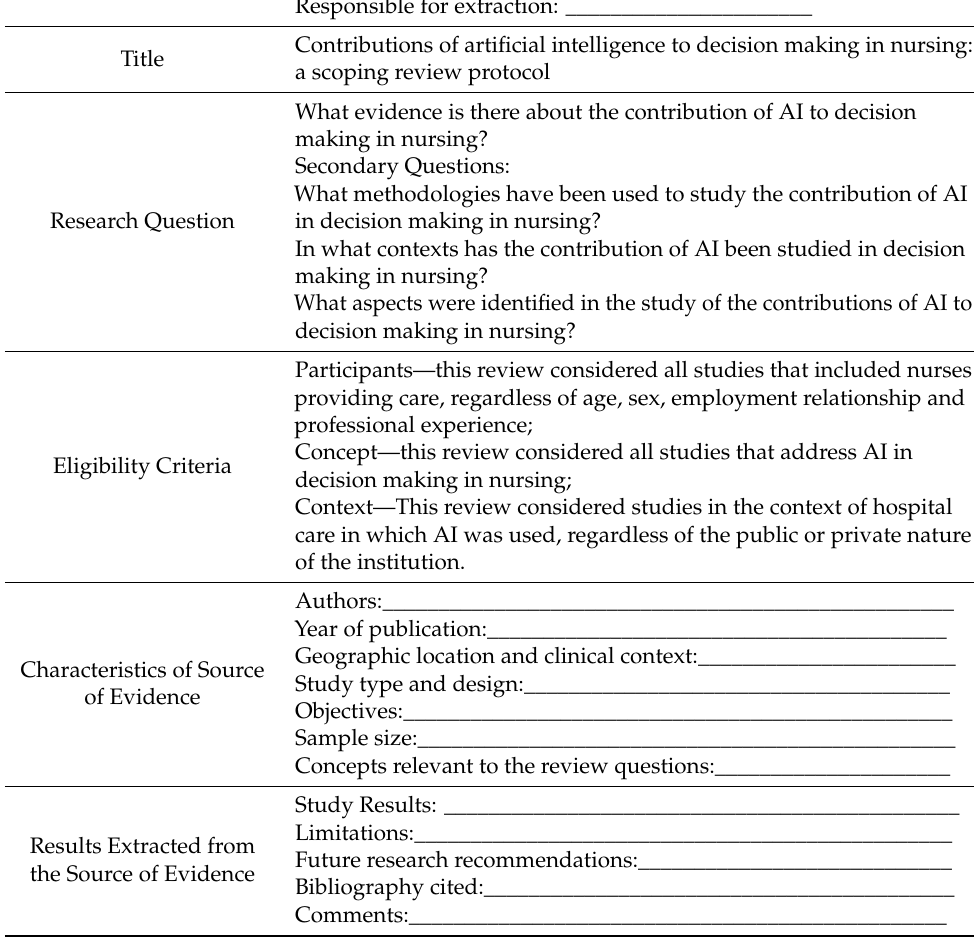
Table 1. Data extraction